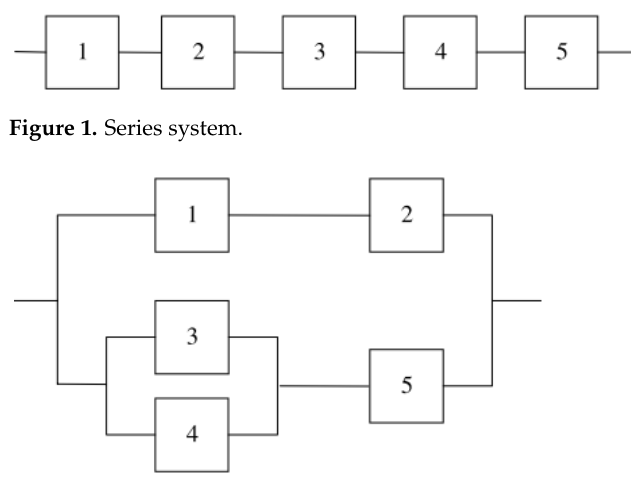
Figure 1. Series system.